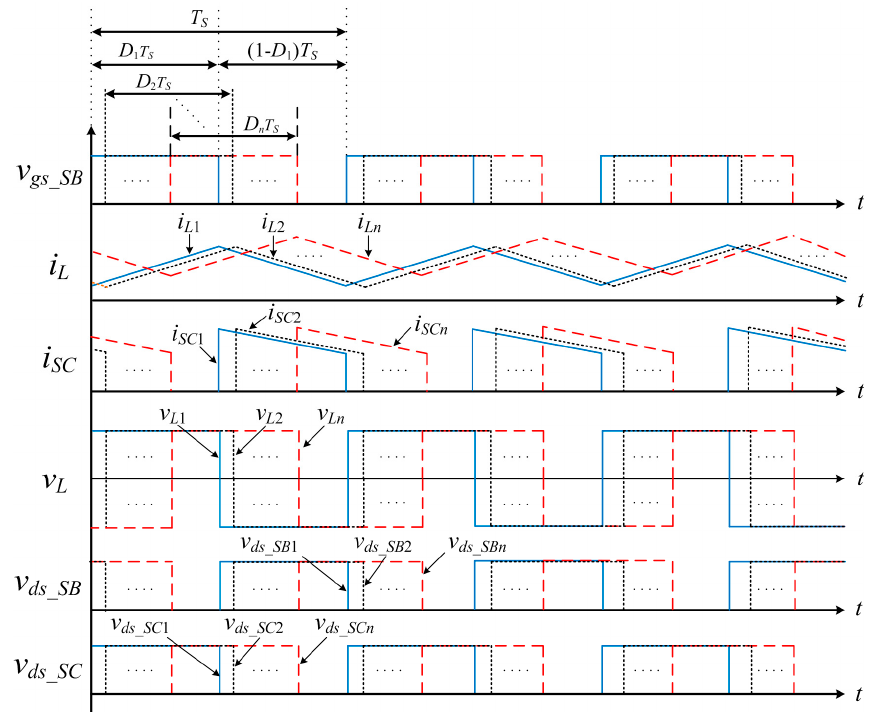
Figure 2. Theoretical waveforms of BPMs with equal phase shift.